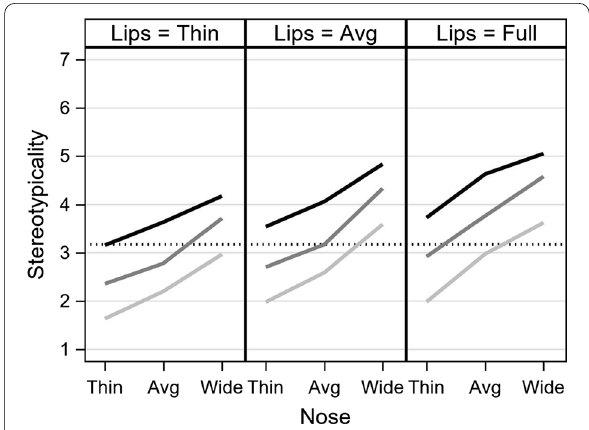
Fig. 4 Model‑predicted stereotypicality ratings. The vertical axis is the predicted stereotypicality score, with a black, dotted line for the model‑implied mean. The horizontal axis represents the levels of nose width. The three lines represent degrees of reflectance (none, medium, high). Each panel represents the degree of lip fullness